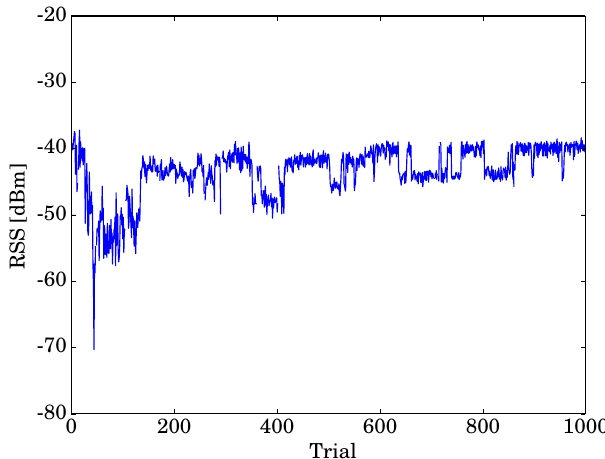
Figure 8. RSS of AP B , measured by sensor node e , as a function of